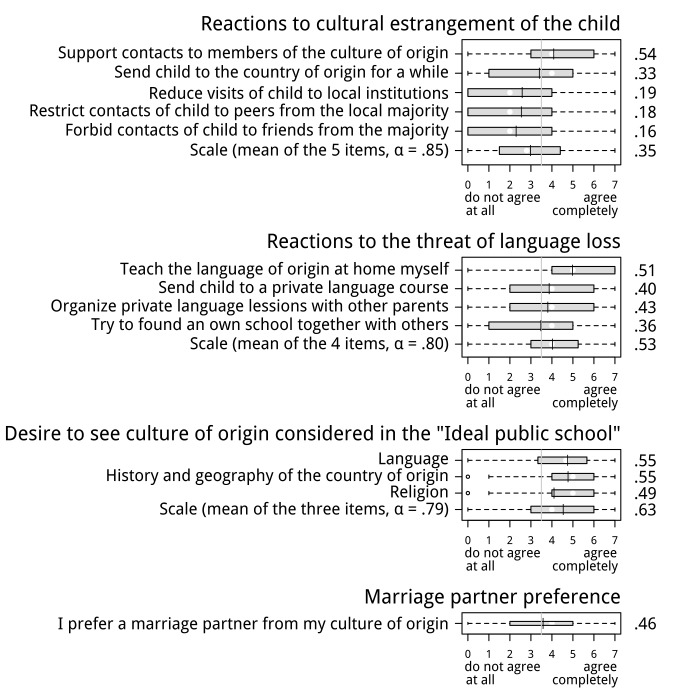
Effects of the culture-transmission motive on action tendencies and desires supportive of cultural transmission.Shown are boxplots of the distributions of the corresponding items. The median is represented by a white circle and the mean by a black bar; the box ranges from the first to the third quartile. The correlation of each item to the culture-transmission motive is listed next to the item on the right side of the figure. All correlations are significant at p <. 001.